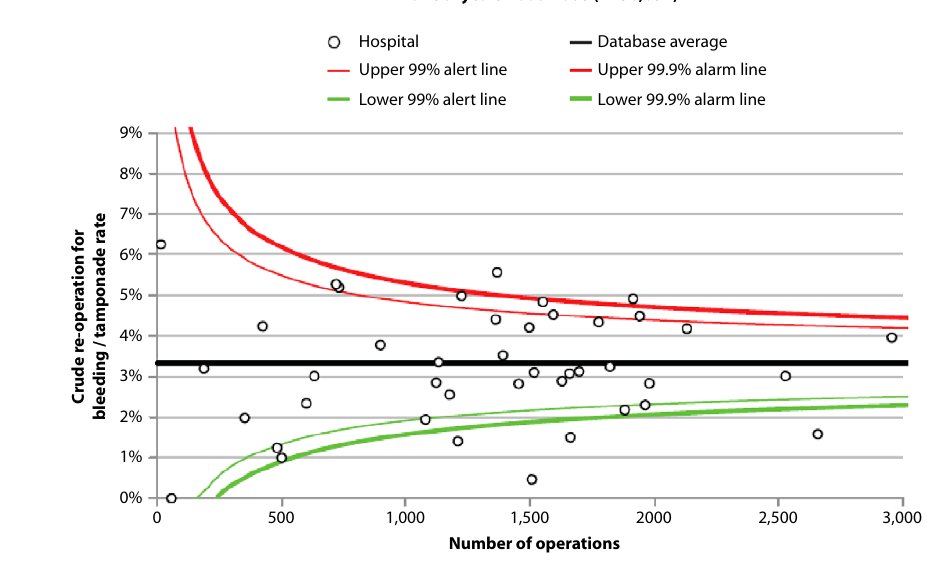
Figure. 2 Funnel plot of the incidence of re-operation for bleeding following CABG in the UK. The average rate was3.2%.AcknowledgementBridgewaterB,KinsmanR,WaltonPandKeoghB.Demonstratingquality:Thesixth National Adult Cardiac Surgery database report: Publisher Dendrite Clinical Systems Ltd. ISBN 1-903968-23-2. 2009. Ref.